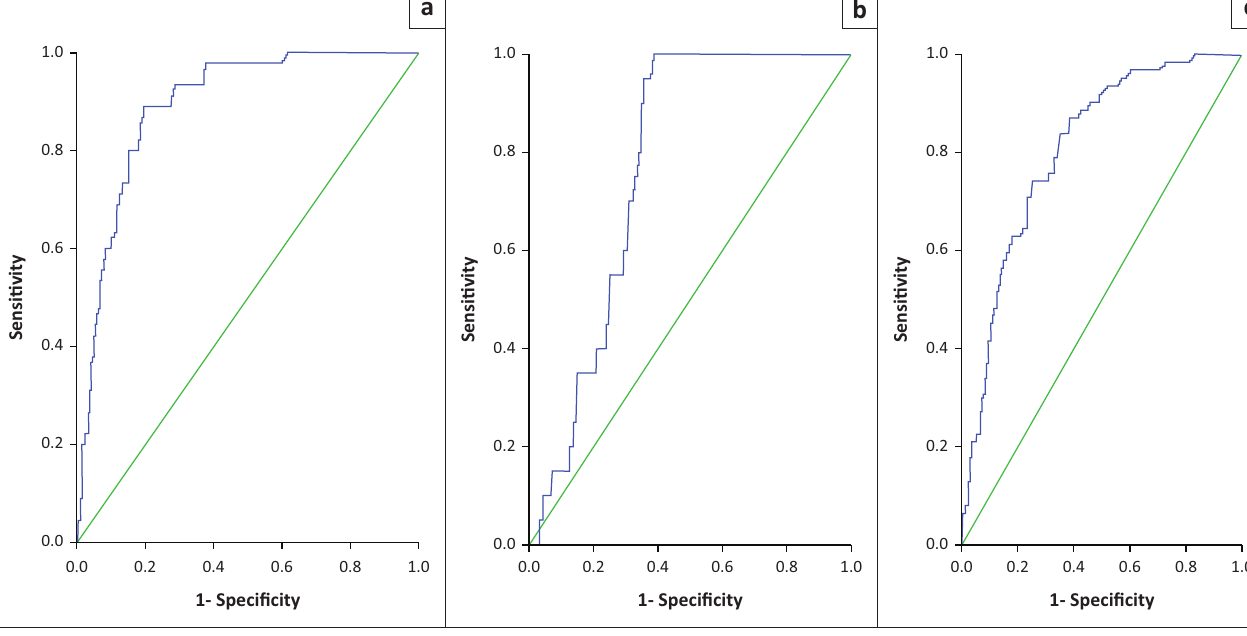
FIGURE 1: Red cell distribution width, ROC curve in SCD phenotypes (haemoglobin SS genotype, haemoglobin SS genotype + haemoglobin F, haemoglobin SS genotype + β-thalassaemia) in western Kenya, 01 January 2015 – 31 December 2020 . (a) Red cell distribution width ROC curve in diagnosis of homozygous SCD. (b) Red cell distribution width ROC curve in diagnosis of sickle cell disease with haemoglobin F. (c) Red cell distribution width ROC curve in diagnosis of SCD with